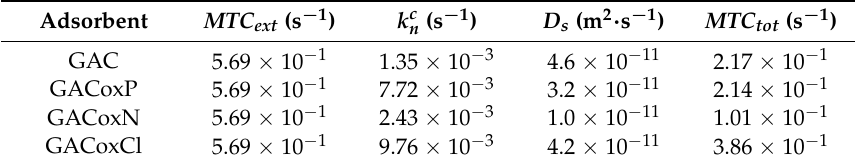
Table 5. Values of the mass transfer coefficients and kinetic fitting parameters of dynamic experimental